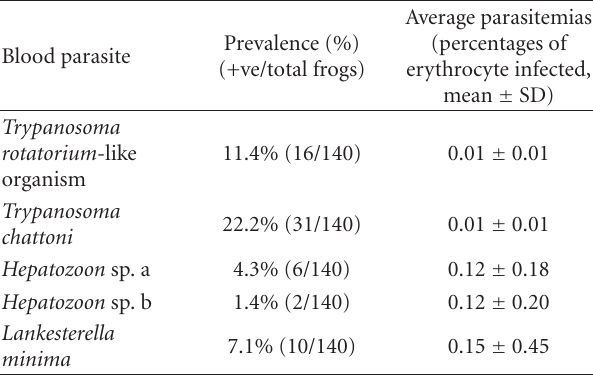
Table 1: The average parasitemias of the infected frogs that were apparently infected with just one species of blood